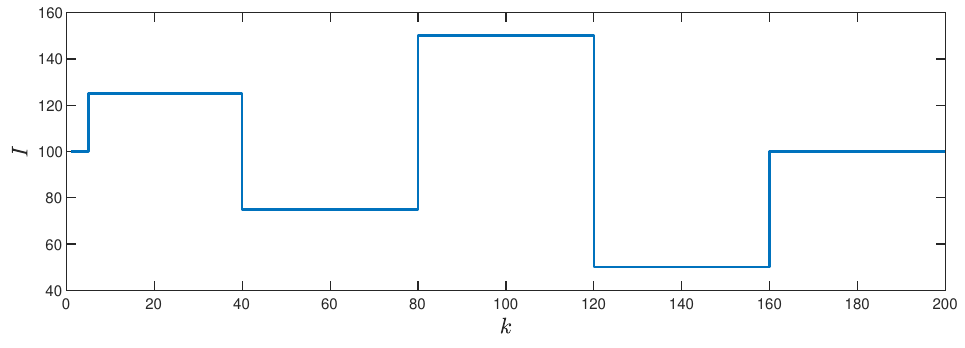
Figure 3. Disturbance step